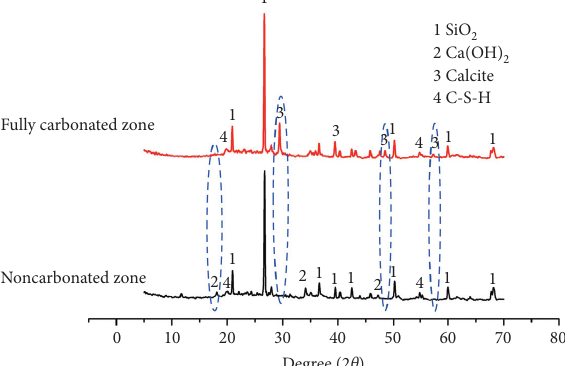
Figure 15: XRD results of different carbonated zones in the